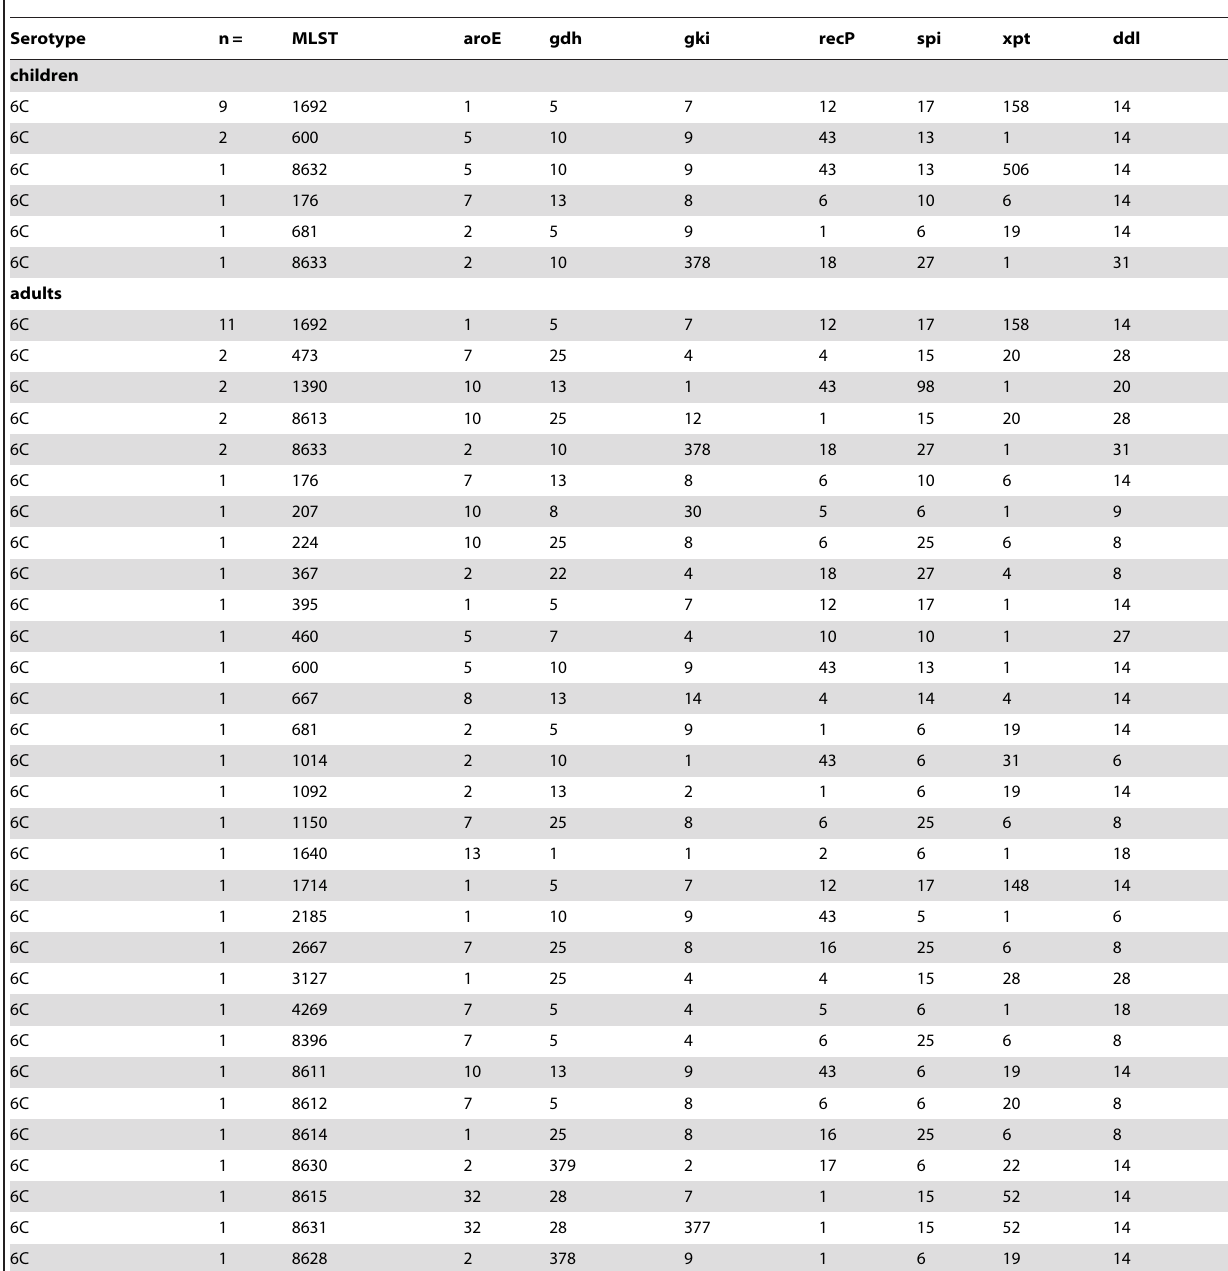
Table 4. MLSTs of serotype 6C isolates from IPD among German children and adults.